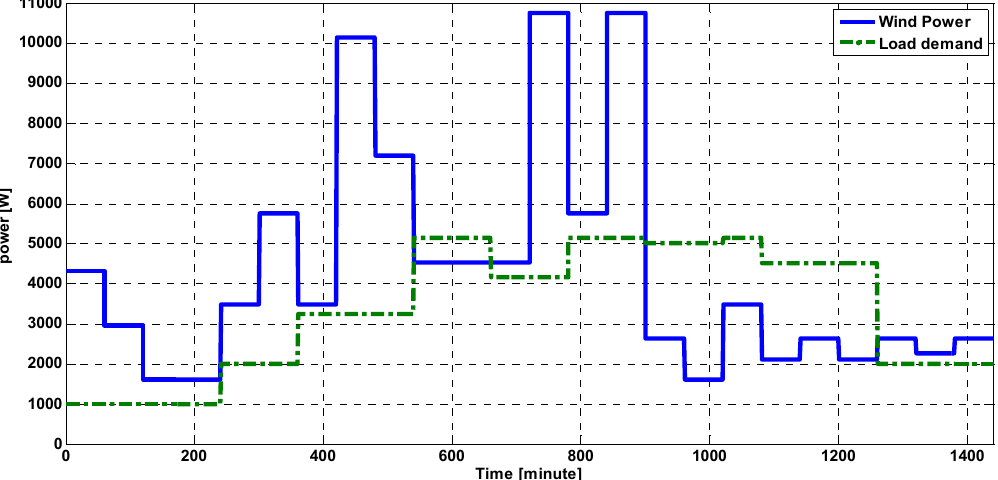
Figure 5. The wind power and demand power curve in minute time